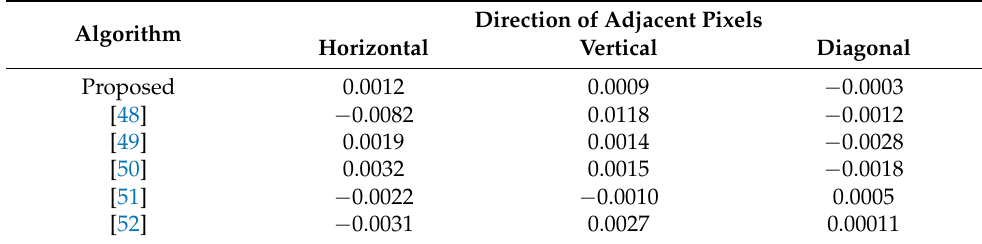
Table 4. Correlation coefficients between various encryption schemes and the proposed scheme.